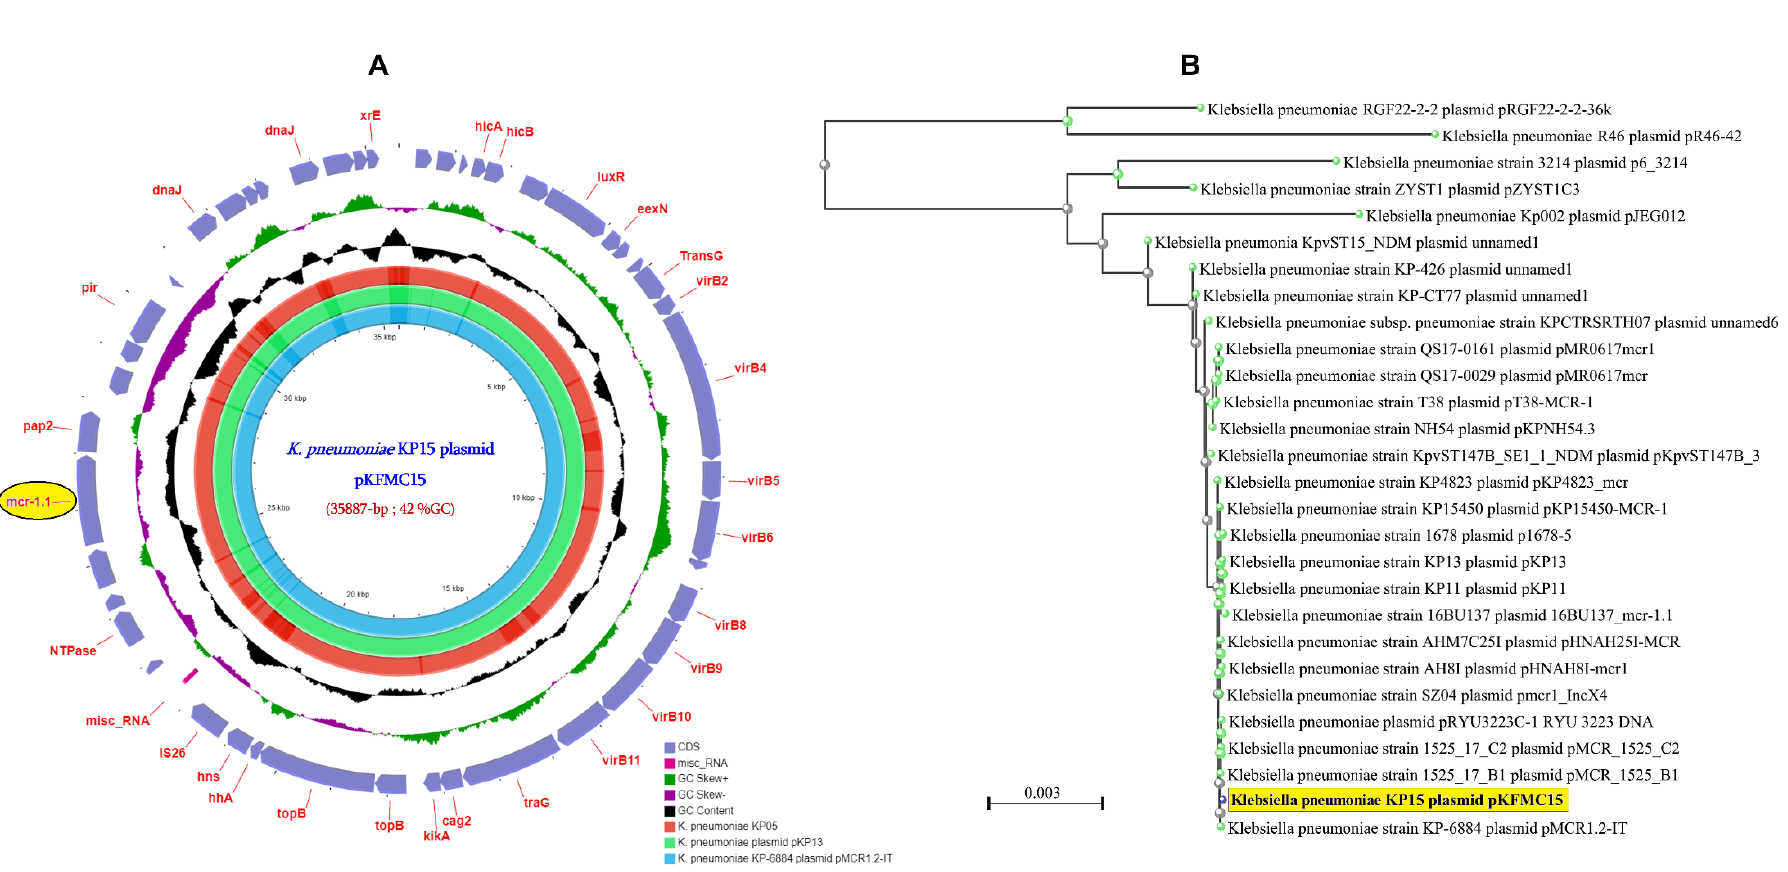
Figure 1. The K. pneumoniae KP15 plasmid pKFMC15 harboring the mcr -1.1. ( A ) The circular representation of this plasmid and its comparison with the closest plasmid sequences retrieved from the NCBI database. As shown in this figure, the same plasmid was identified in the K. pneumoniae KP05 strain isolated from the same hospital. ( B ) The phylogenetic relationship with the most closely related plasmids from the NBCI database.